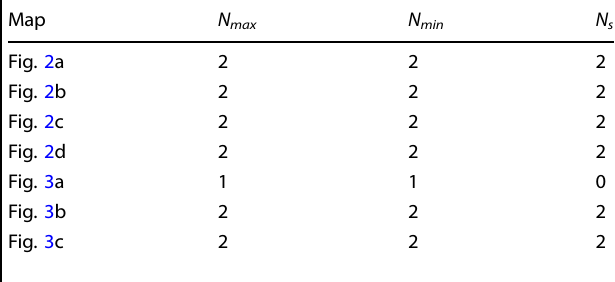
Table 1. The number of maxima, minima, and saddle points of each anisotropy map. N max is the number of maxima, N min is the number of minima, and N s is the number of saddle points. The numbers for Fig. 2e and f are not included since they have higher-order critical